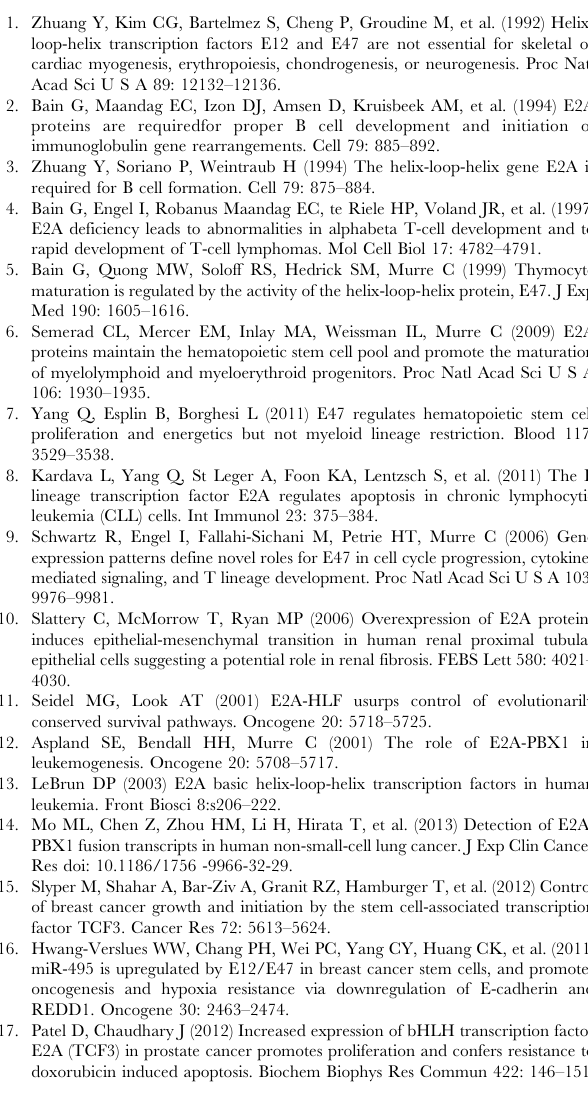
Figure S1 (A) Left: E2A protein expression of wild type SW480, control SW480, and knocked-down SW480 cells. Right: Change of E2A expression in SW480 cells after transfection of shE2A, E12 or E47: shE2A reduced the expression of E2A in SW480, while E12 and E47 increased E2A expression in SW480/shE2A cells, relative to the controls; (B) Transfection of E12 or E47 inhibited SW480/WT cell growth; (C) E2A regulates cell growth in NCM460 cells; (D) Transfection of E12 or E47 increased G 0 /G